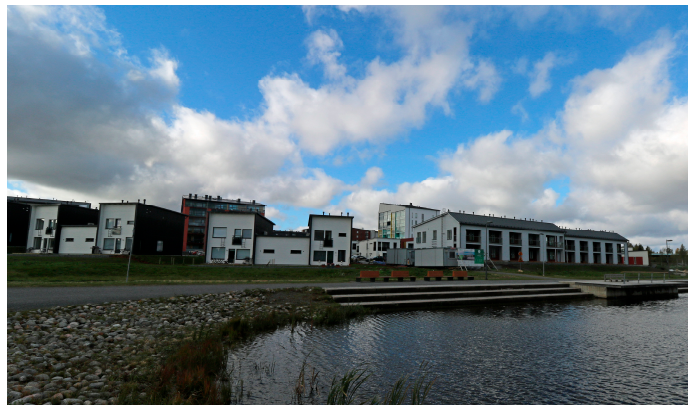
Figure 3. View of the storm water retention pond in Vuores Central Park. (Photo: Pekka Huovila).